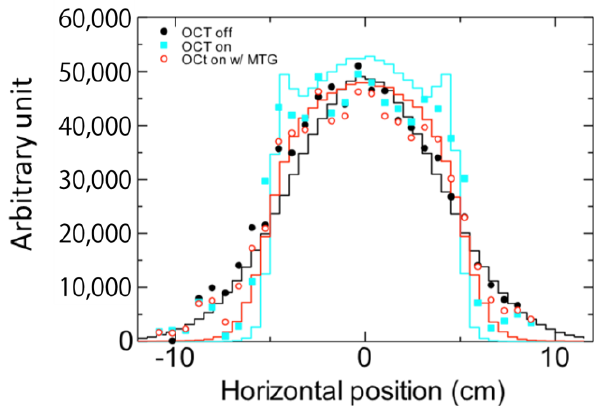
Figure 20. Proton beam profile with nonlinear optics caused by the octupole magnets. Dots stand for